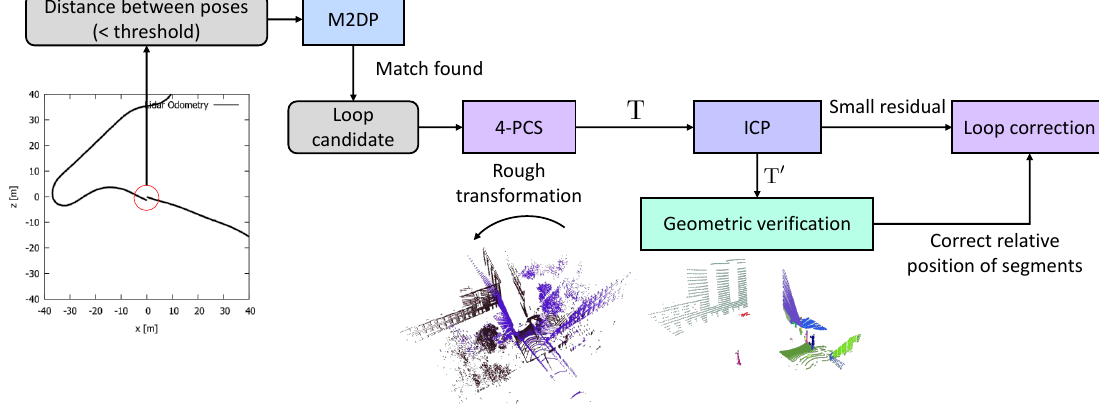
Figure 1. Our loop detection and correction pipeline, consisting of five main algorithms. The global descriptor MD2P detects loop candidates, after which the 4-PCS and ICP algorithm try to align